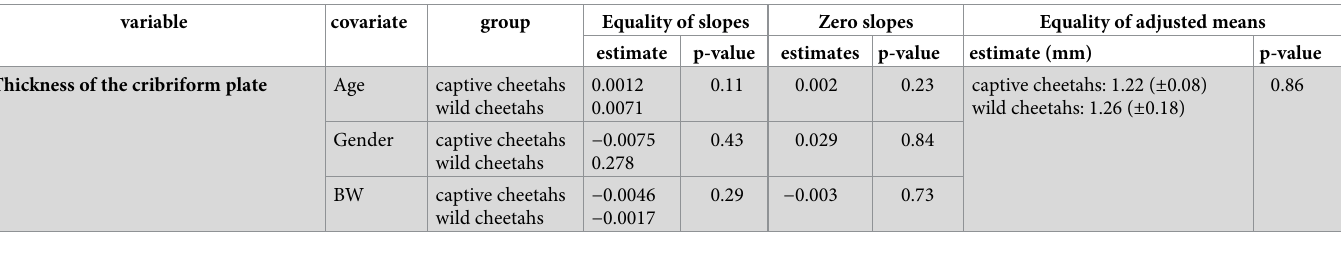
The table presents results of the comparison of the equality of regression coefficients (slopes) on the body weight and the equality of adjusted means at BW = 33 kg. Significantly different estimates and p-values are in bold and underlined which represent the result of pairwise comparison. Normal typed estimates and p-values are not significantly different and represent the result of global comparison.